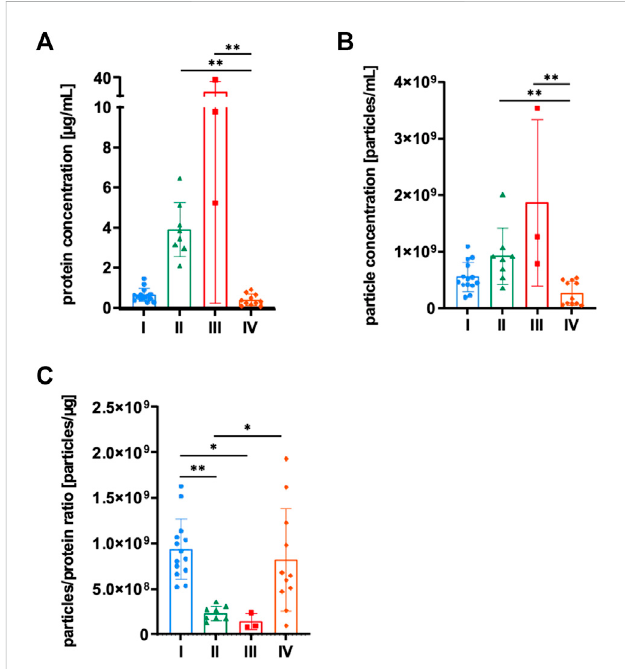
Quanti fi cation of sEVs. MSCs were grown in α MEM+8% PL, and sEVs were collected in CM for 24 – 48 h prior to isolation by methods I (blue), II (green), III (red), and IV (orange). (A) Protein concentration and (B) particle concentration of sEV preparations were determined by BCA assay and NTA, respectively. (C) Particles to protein ratio was calculated for information on purity of isolated sEVs. Data are presented as mean ± SD and N ≥ 3 independent experiments were performed. Statisticallysigni fi cantdifferencesaredepictedasfollows:*: p < 0.05, **: p <